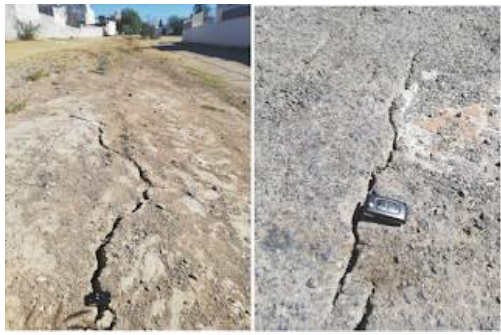
Figure 4. Fissures associated to the earthquake occurred in 6 April